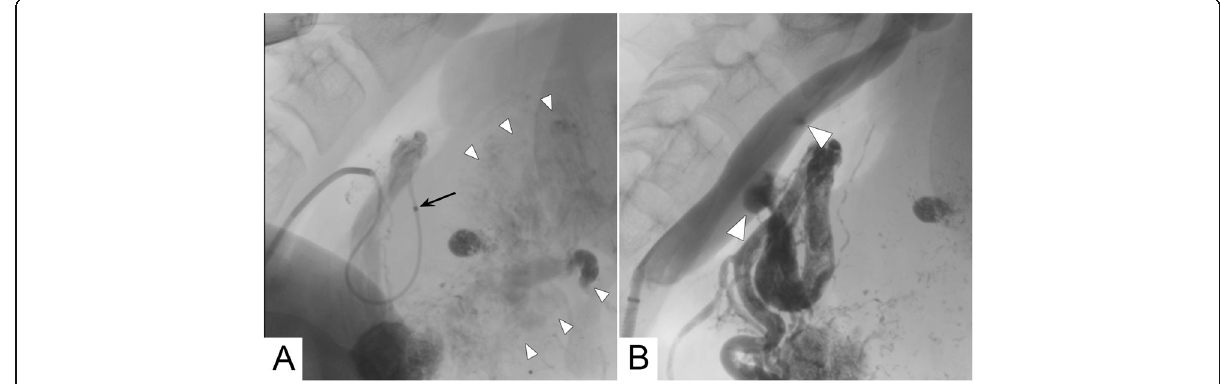
Fig. 2 ( a ) Super-selective angiography of the AVM. Black arrow indicates the microcathetertip before embolization. Small white arrowheads outline the large facial AVM. ( b ) Control angiography from the common carotid after embolization. The microcatheter has been removed. White arrowheads indicate NBCA deposits in the common carotid, secondary to accidental reflux of the embolic agent during vigorous